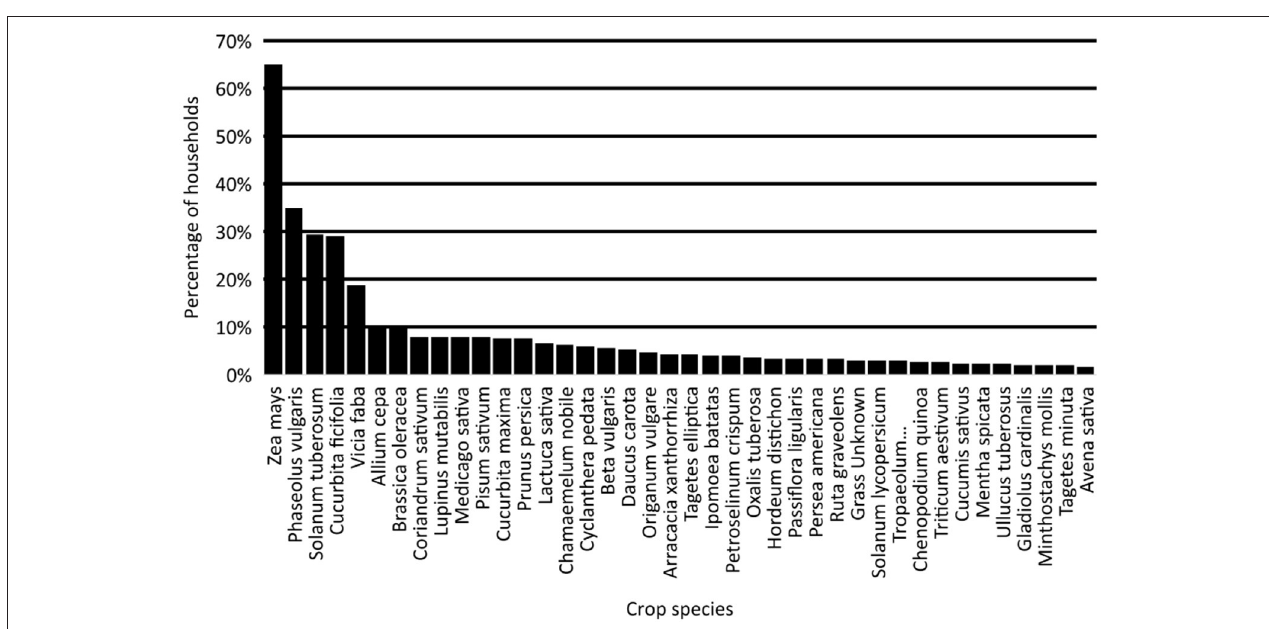
FIGURE 3 | Frequency of cultivated species in crop fields of households ( n